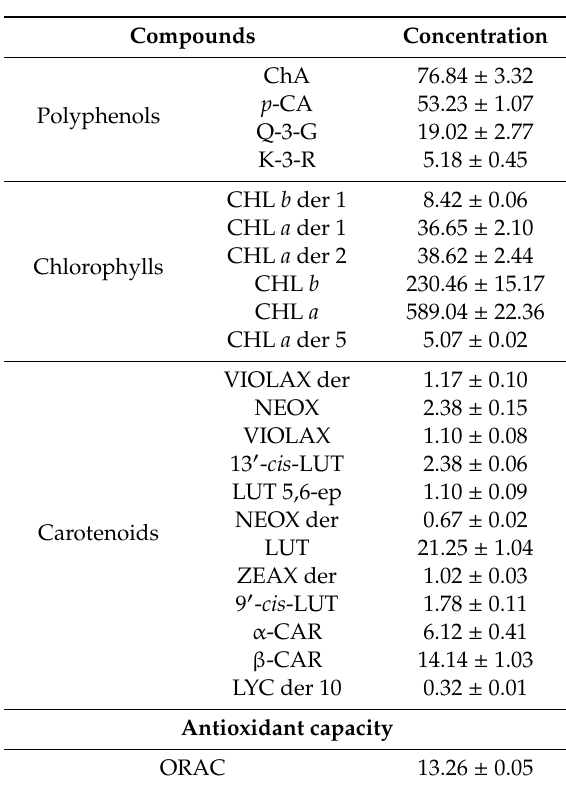
Table 3. Nettle leaves polyphenols (mg 100 g − 1 dm), pigments (mg 100 g − 1 dm) and ORAC